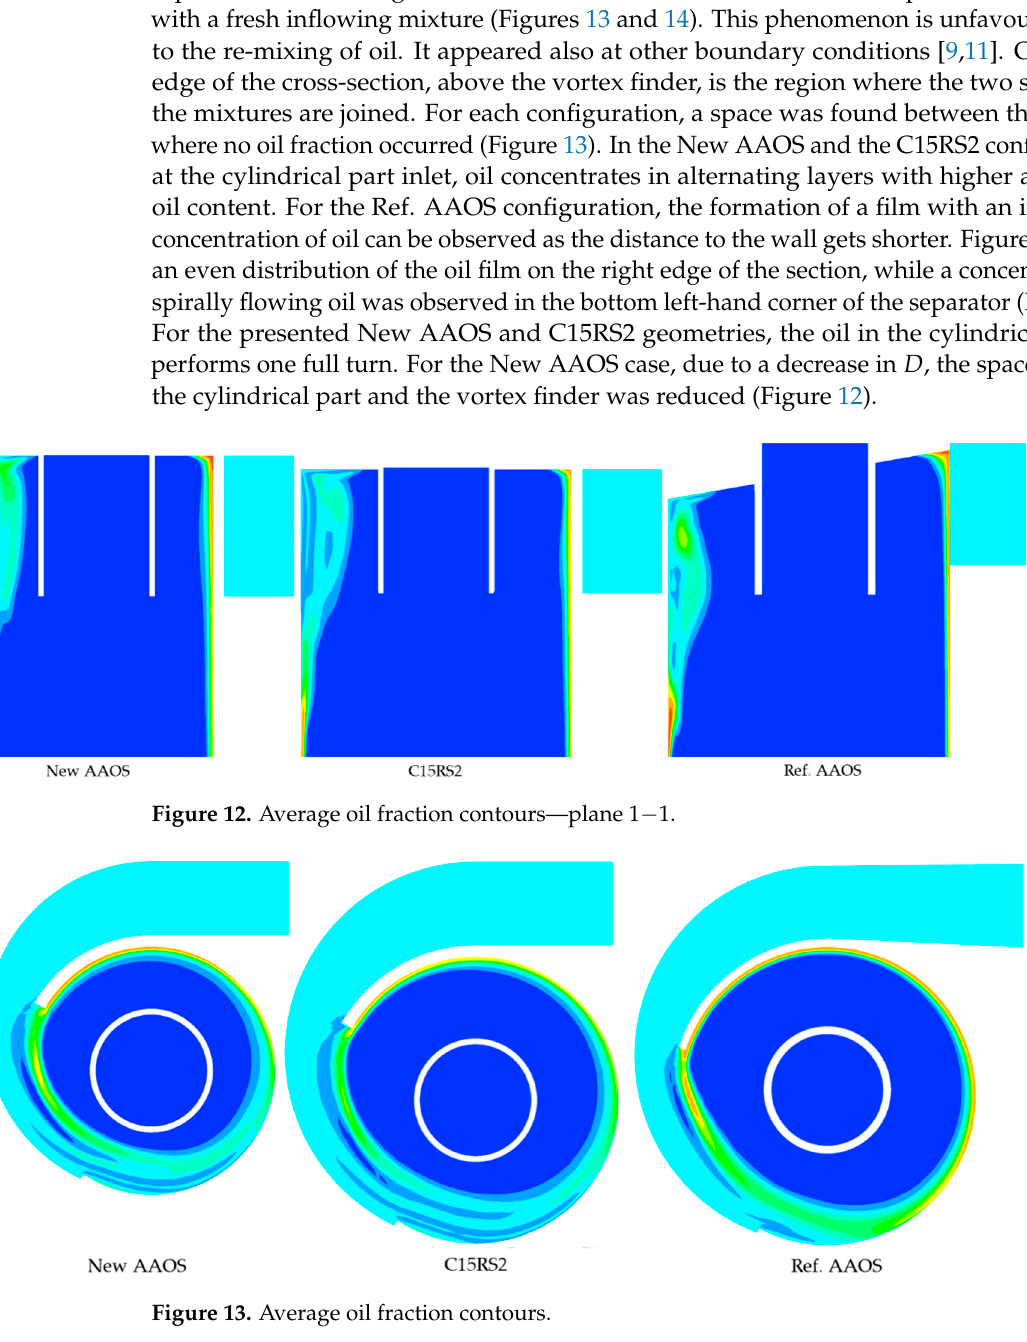
Figure 13. Average oil fraction contours.